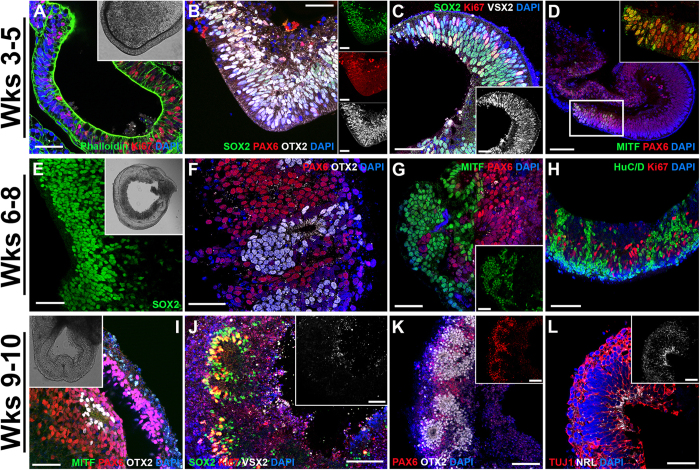
Early 3D organoid development in patient-specific iPSCs.Immunocytochemical analysis of 3D organoids after 3–5, 6–8 and 9–10 weeks of differentiation. (A–D) After 3–5 weeks of differentiation, 3D spheres have evaginated loops comprised of polarized F-actin-positive structures (A and inset; Phalloidin; green) and proliferating, Ki67-positive neural epithelia (A; red). At this stage, spheres express SOX2 (B; green), PAX6 (B; red) and OTX2 (B; gray) and have the appearance of developing organoids. Many cells positive for SOX2 (C; green) also express VSX2/CHX10 (C and inset; gray). There are isolated pockets of presumptive RPE cells that co-express MITF (D and inset; green) and PAX6 (D and inset; red). (E–H) After 6–8 weeks, organoids are multilayered structures (E and inset) that continue to express SOX2 (E; green). Some organoids begin to develop pockets of photoreceptor precursor cells within neural rosette-like structures that express OTX2 (F; gray), independently of PAX6 (F; red). Areas of pigmented cells that express MITF (G and inset; green) independently of PAX6 (G; red) are also observed. There is a subpopulation of cells that express the neuronal factor, HuC/D (H; green), an early marker of amacrine and ganglion cells and cell proliferation continues at a high rate (H; Ki67; red). (I–L) After 9–10 weeks, 3D organoids begin to look morphologically similar to a mature retina (inset of I) and in some cases have a laminated structure with an outer layer of MITF-positive, RPE cells (I; green) with underlying PAX6-expressing cells (I; red) and clusters of OTX2-positive photoreceptor precursor cells (I; gray). Within neural rosettes, SOX2-positive cells (J; green) now lack VSX2/CHX10 (J and inset; gray) and have fewer Ki67-positive cells (J; red). OTX2 (K; gray) is robustly expressed independently of PAX6 (K and inset; red) throughout neural rosettes that are now more widespread and larger in size (K). Many cells throughout the organoids are now positive for the pan neuronal marker, TUJ1 (L; red), but do not yet express the rod photoreceptor-specific factor, NRL (L and inset; gray). Small panels to the right of B show individual fluorophores. Scale bars = 50 μm, except for D = 100 μm.